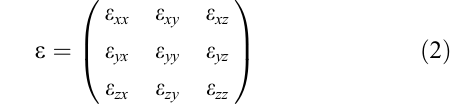
Figure 1. For a rectangular coordinate system ( x , y , z ), the general position of the optic axis in a uniaxial crystal can be set at an angle h to the z -axis. This axis then has a projection on the ( x , y ) plane, which is at an angle / to the x